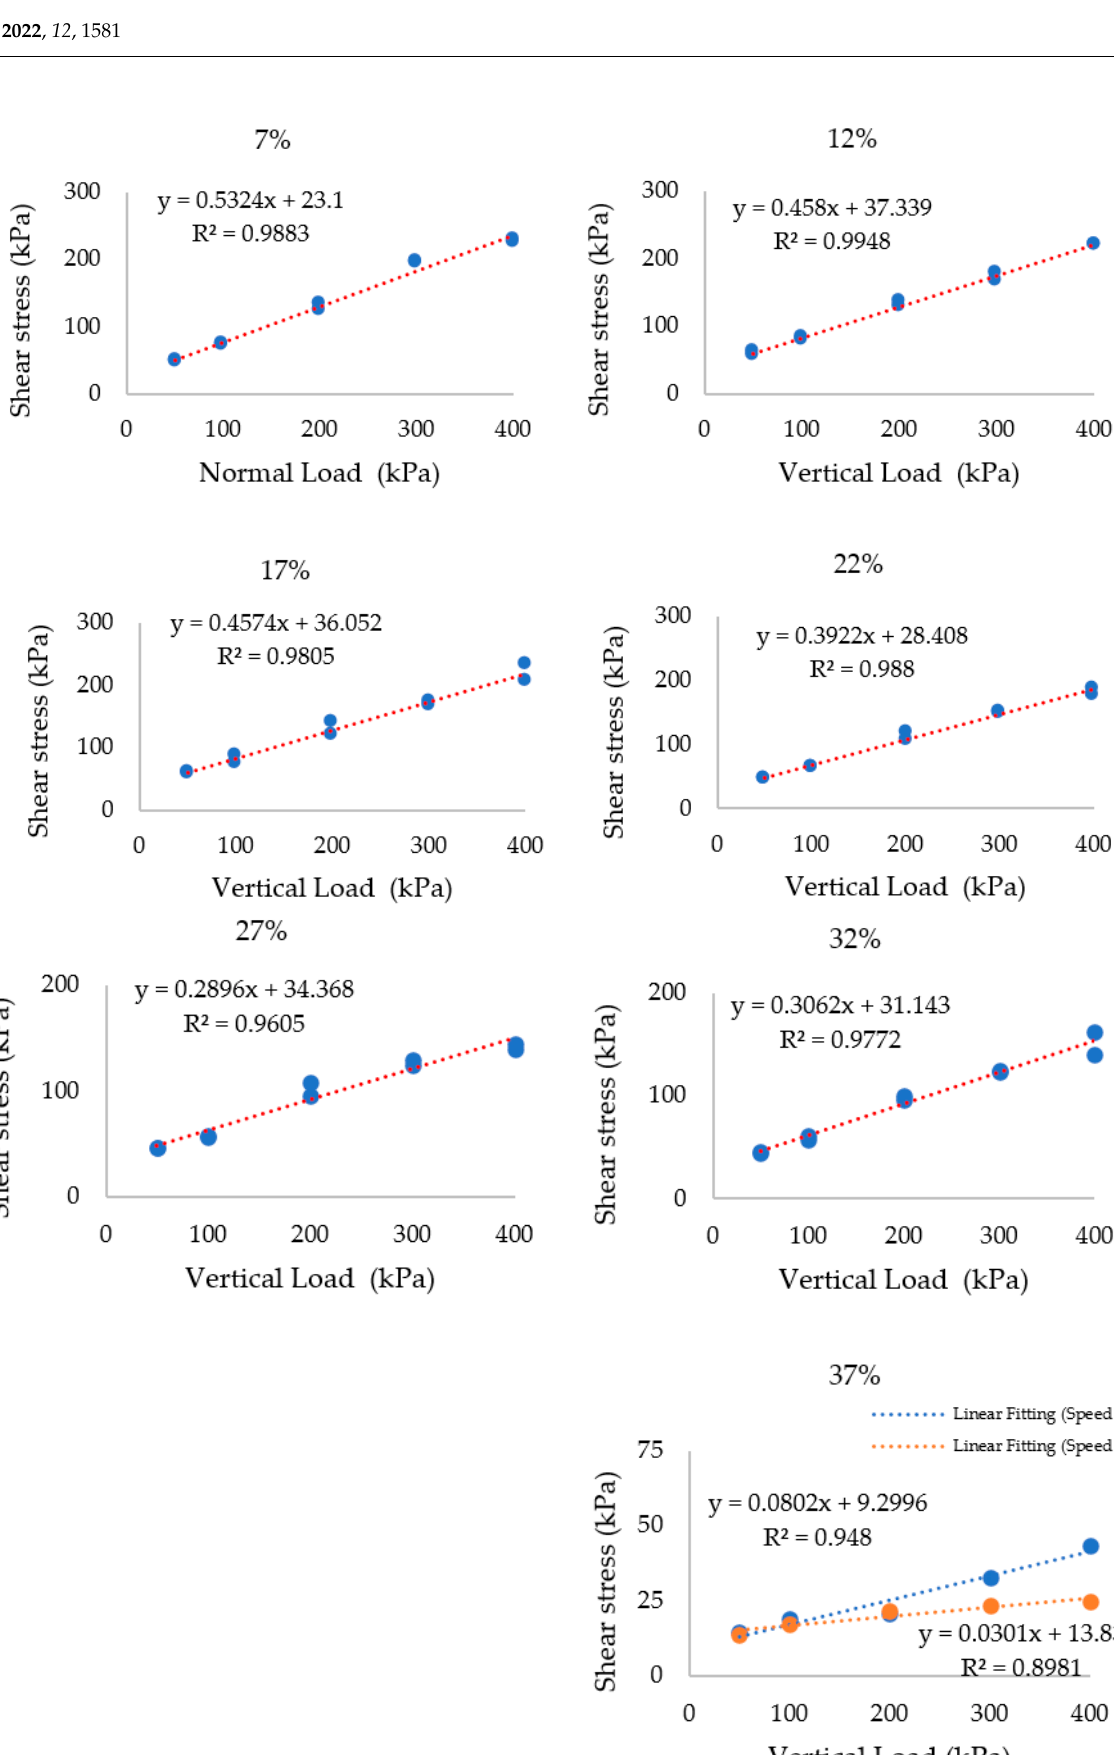
Figure 11. Shear stress varies with the increase in vertical load.